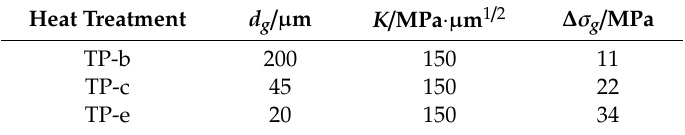
Table 6. Relevant parameters and calculated results of the grain boundary strengthening.